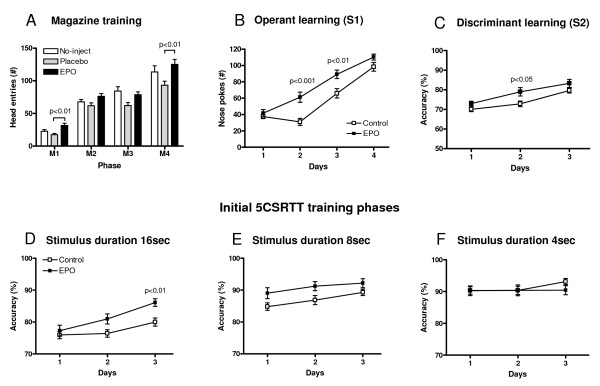
Analysis of distinct sequential learning phases. (A) Number of head entries as indicators of associative learning in magazine training (M1–4) show an overall significant effect of EPO treatment compared with placebo. (B) Number of nose pokes in the operant learning phase (S1) as well as (C) percentage of correct nose pokes in the discriminant learning phase (S2) were higher in the EPO-treated compared with the control group (placebo plus no-inject). (D, E) Initial cognitive performance in the 5CSRTT was better upon EPO treatment in the 16-sec and 8-sec stimulus duration phases, but no longer in the 4-sec phase (F); n = 14–28 per group; data presented as mean ± S.E.M.; all significance values refer to post hoc tests which were only significant if ANOVA was also significant; in (E), only ANOVA was significant (P = 0.03).